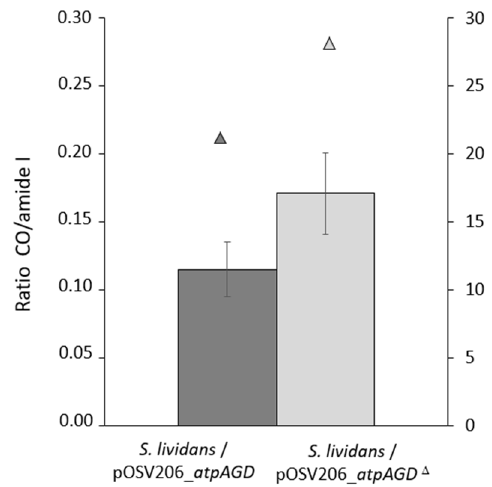
Figure 6. Fourier Transform Infra Red Spectroscopy (FTIRS) analysis of total lipid content of S. lividans /pOSV206_ atpAGD (dark grey histograms) and S. lividans /pOSV206_ atpAGD ∆ (light grey histograms) grown at 28 °C for 72 h on R2YE with no K2HPO4 added. Triangles above the histograms represent the biomass of the strains expressed as mg of dry mycelium per plate.